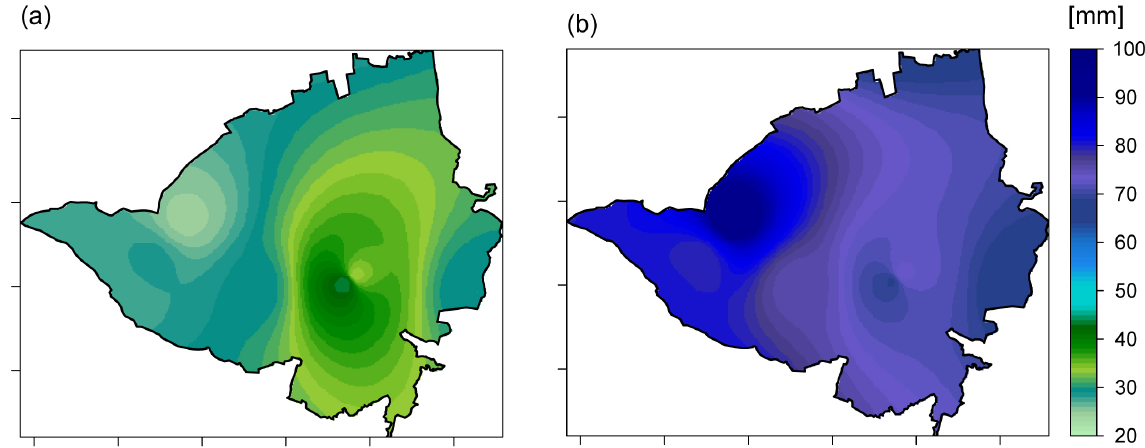
Figure 10. Spatial interpolation of rainfall events in El Batán Sub-basin ( a ) With duration D = 30 min and ( b ) With duration D = 1440 min and return period T = 20.